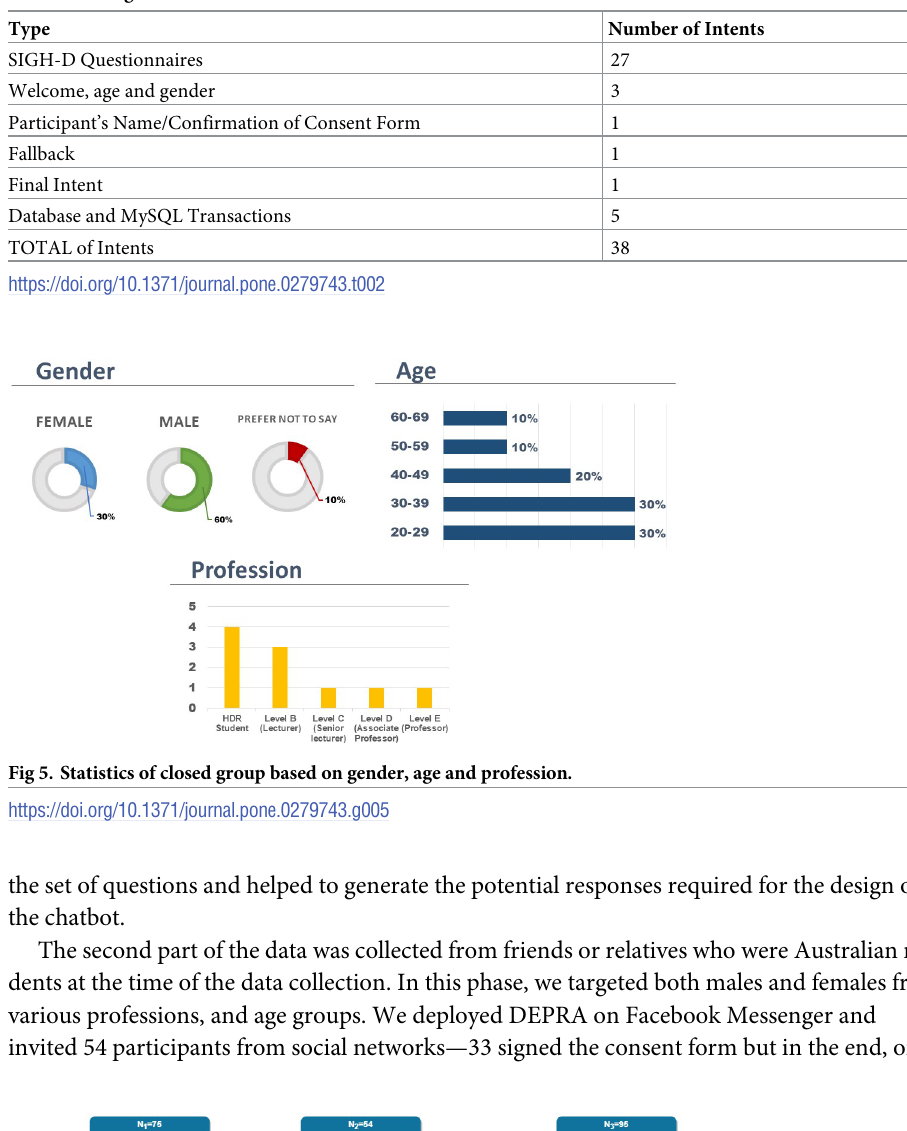
Table 2. Dialogflow intents breakdown.